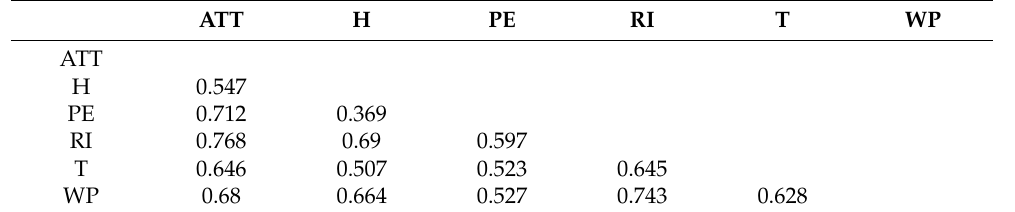
Table 4. Heterotrait–Monotrait ratio (HTMT).